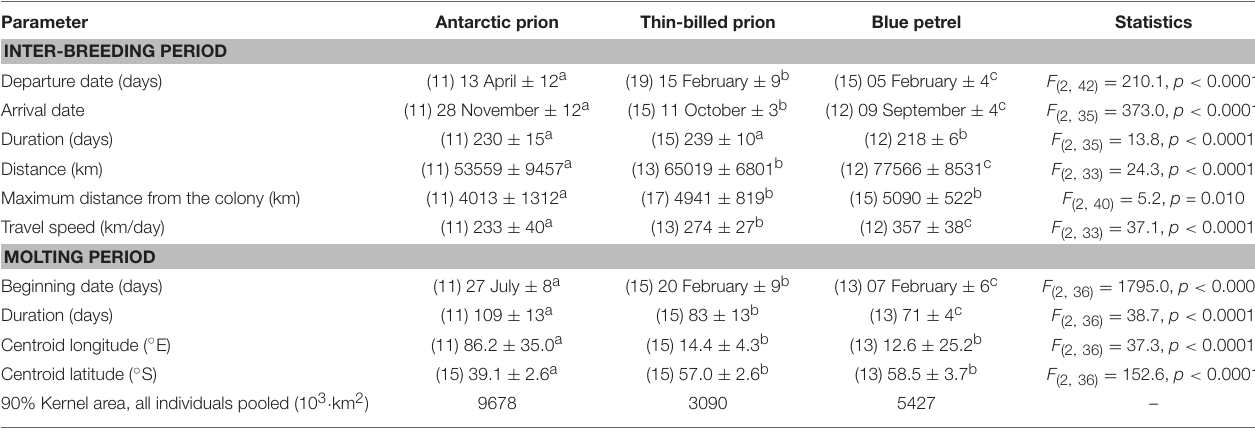
TABLE 2 | Main characteristics of the inter-breeding and molting periods of Antarctic and thin-billed prions and of blue petrels from the Kerguelen Archipelago in 2012. Parameter Antarctic prion Thin-billed prion Blue petrel Statistics INTER-BREEDING